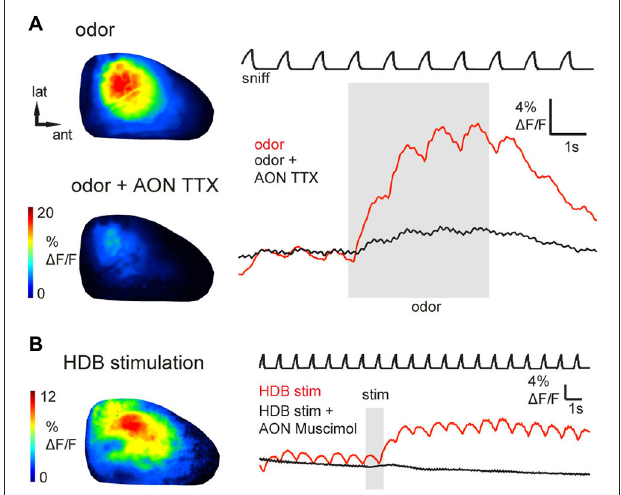
FIGURE 3 | Epifluorescence signals arise from AON activity and can be activated by basal forebrain stimulation. (A) Odorant-evoked (1% ethyl butyrate) GCaMP6s signals before and after injection of TTX into AON (see Text for details). Shown are odorant response maps (left) and optical signal traces (right) taken immediately before (upper map, red trace) or after (lower map, black trace) TTX injection. TTX injection into the AON reduced odorant-evoked responses in the OB. (B) Response maps and time-course of GCaMP6s signals evoked by electrical HDB stimulation, displayed as in (A) . HDB stimulation caused prolonged fluorescence increases in AON axon terminals (red trace). Black trace shows GCaMP6s signal from the same region of interest shortly after injection of muscimol into AON. AON inactivation with muscimol abolished inhalation- and HDB stimulation-evoked responses in the